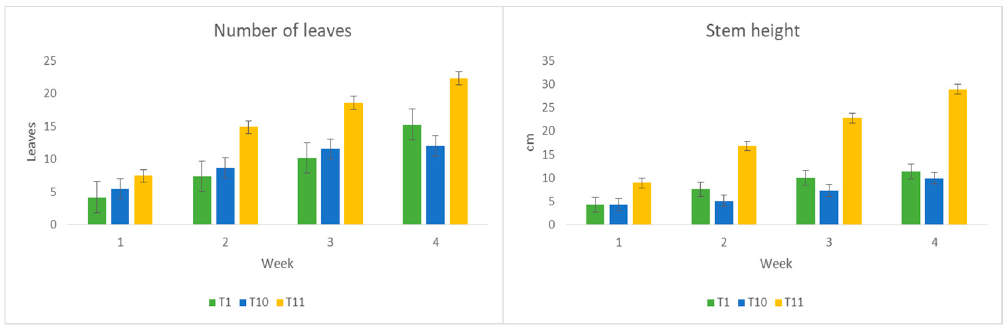
Figure 9. The morphological response for Brassica chinensis under T1, T10, and T11.